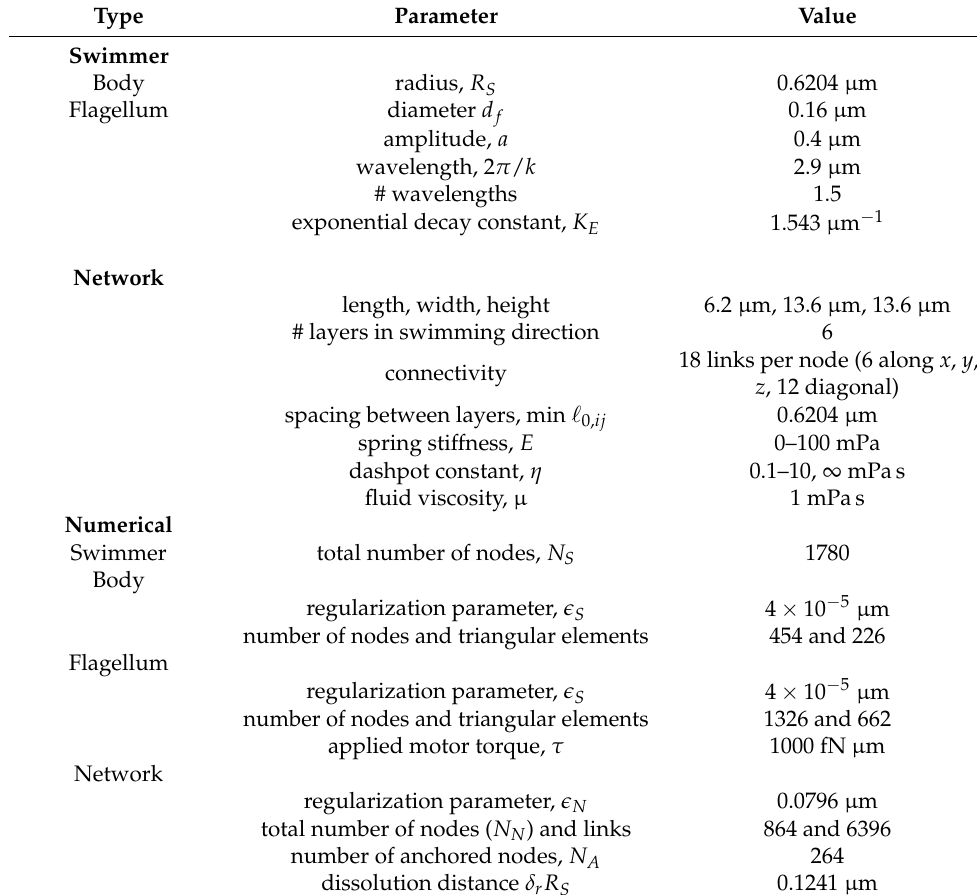
Table 1. Physical and numerical parameter values used in this